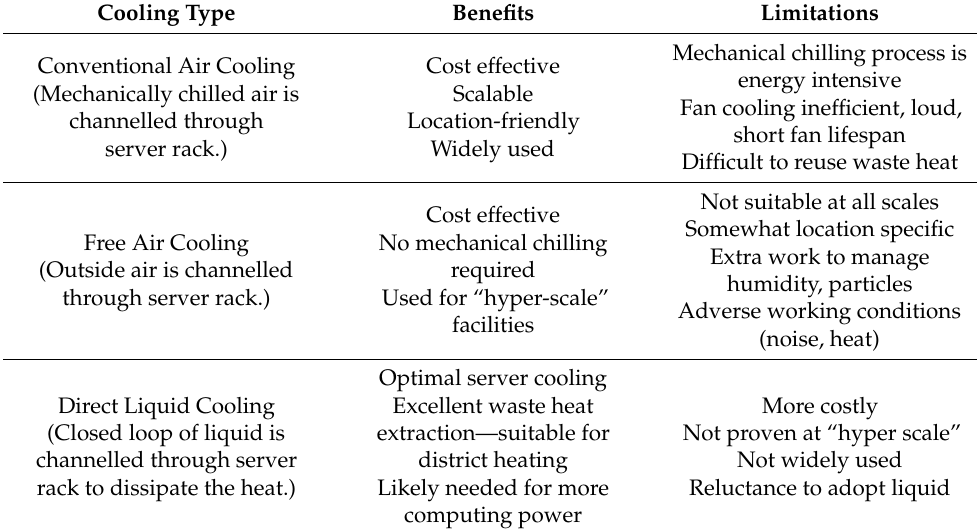
Table 1. Summary of key data centre server cooling